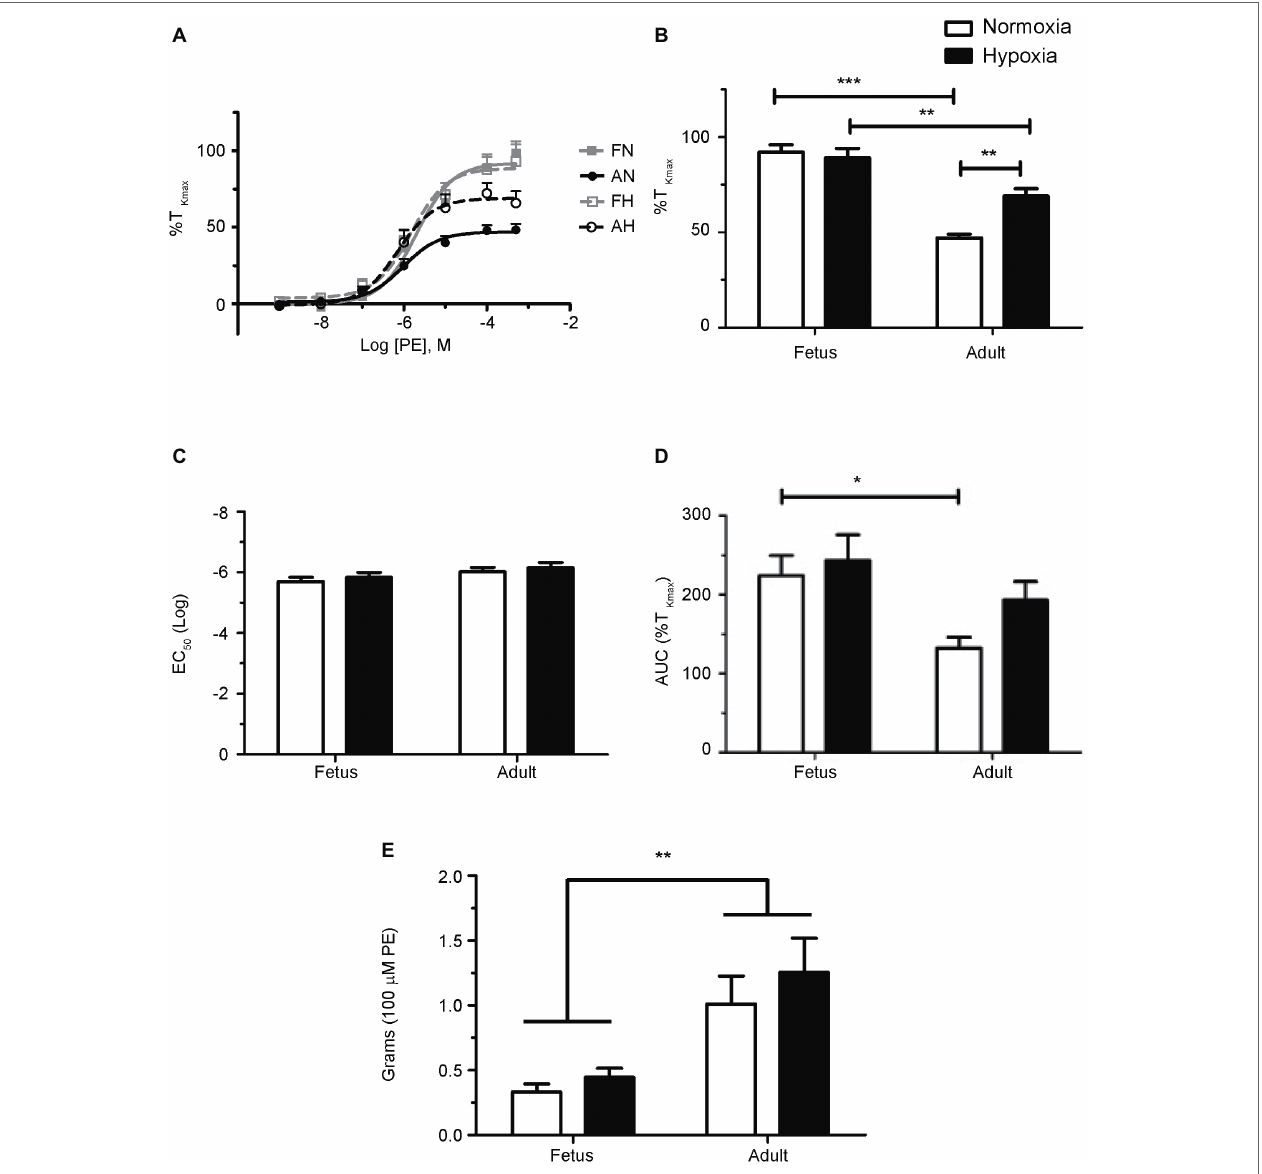
FIGURE 1 | Phenylephrine-mediated contraction of pulmonary arteries from sheep is depressed in the adult period and enhanced by LTH. (A) Dose-response curves of pulmonary arterial rings exposed to 1 nM to 100 μM of phenylephrine in an additive manner from normoxic (solid lines) and LTH (dashed lines) fetal (gray lines and boxes) and adult (black lines and circles) sheep. Curves are plotted in relation to the maximal contraction induced by initial stimulation of 125 mM K + Krebs-Henseleit solution (%T Kmax ). (B) Maximum contraction relative to %T Kmax . (C) Log EC 50 for phenylephrine induced contraction. (D) Area under the dose-response curve relative to high K + contraction. (E) Absolute force developed for 100 μM phenylephrine-induced contraction. Points and bars are mean values and error bars indicate ± S.E.M. Comparisons between groups were made using a two-way ANOVA with a Bonferroni post hoc analysis (* p < 0.05, ** p < 0.01, *** p < 0.001). Numbers of animals for each group are provided in the “Methods”